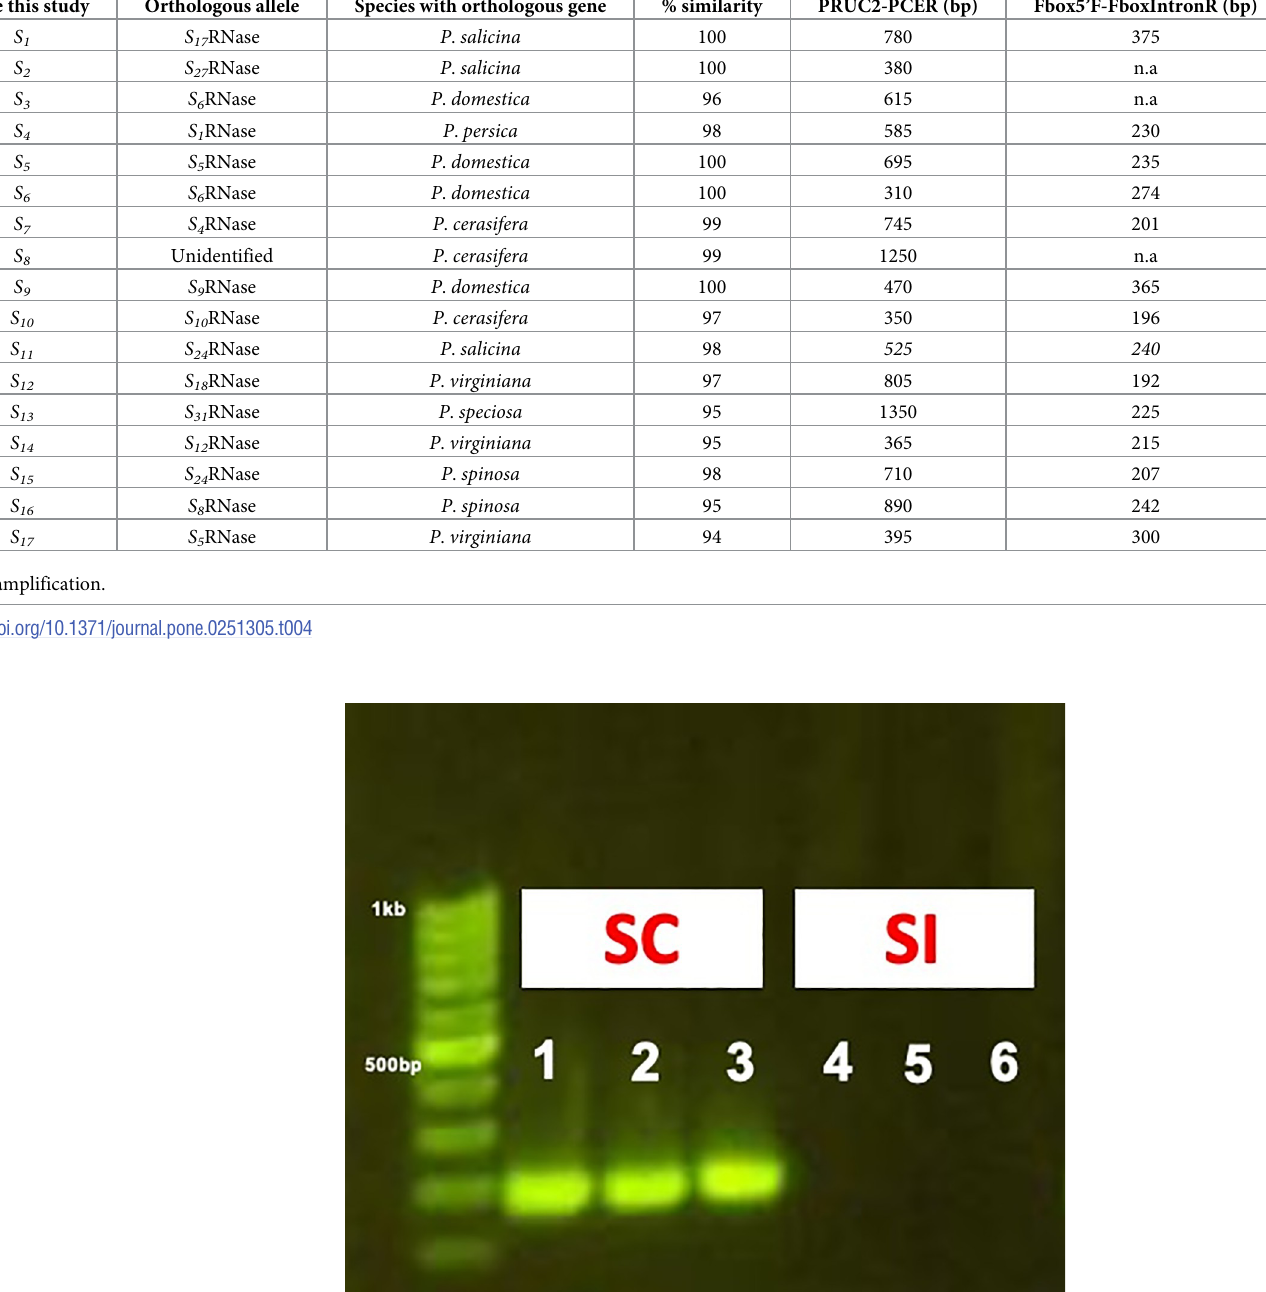
Table 4. Size in base pairs (bp) of the new S alleles discovered in this study for RNase and SFB genes and sequence similarities with S- RNase alleles from a range of species in the genus Prunus . Allele this study